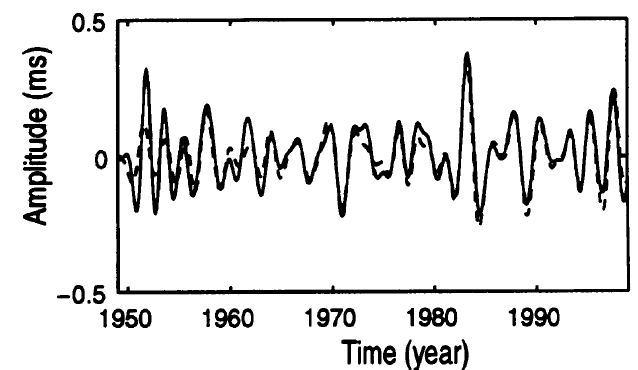
Fig. 6. Interannual variations (between 1.5 and 5 years) of the LOD ( solid ) and AAM (i.e. NCEP 10 ) ( dashed ) W